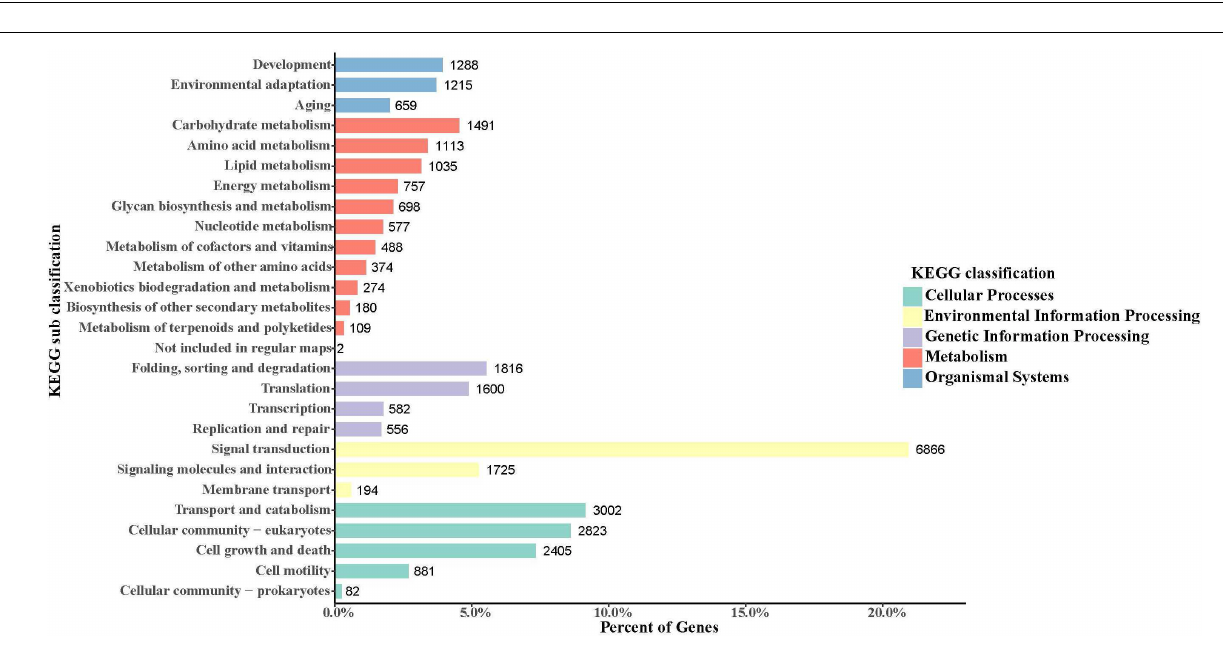
found, including DNA-directed RNA polymerase III subunit RPC2 ( POLR3B ), phosphatidylinositol 3-kinase catalytic subunit type 3 ( PIK3C3 ), E3 ubiquitin-protein ligase Topors ( TOPORS ), fast kinase domain-containing protein 3 ( FASTKD3 ), cytochrome P450 1A1 ( CYP1A1 ), and Uveal autoantigen with coiled-coil domains and ankyrin repeats protein ( UACA ) ( Table 2